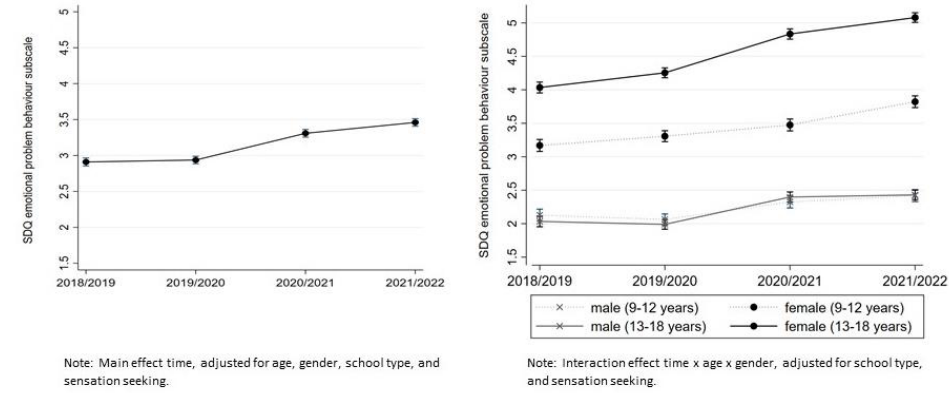
Figure 2. Mean SDQ subscale emotional problems scores from 2018 – 2019 to 2021 – 2022, cross-sec- scale ranges from 0 to 5 (abnormal problem behavior).